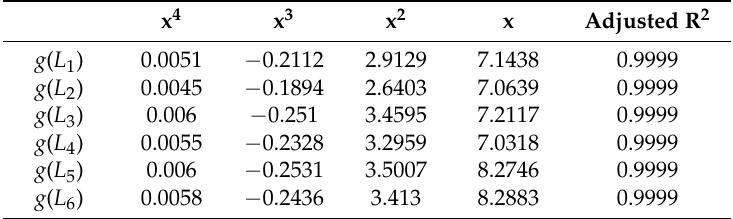
Figure 10. Workplane illuminance according to the dimming levels. Table 1. Regression equations of g(Lj) of the dimming level illuminance at the workplane.